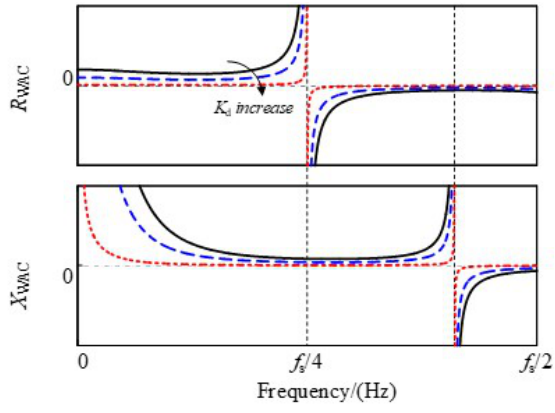
Fig. 12. Frequency characteristic curve of R WAC1 and X WAC1